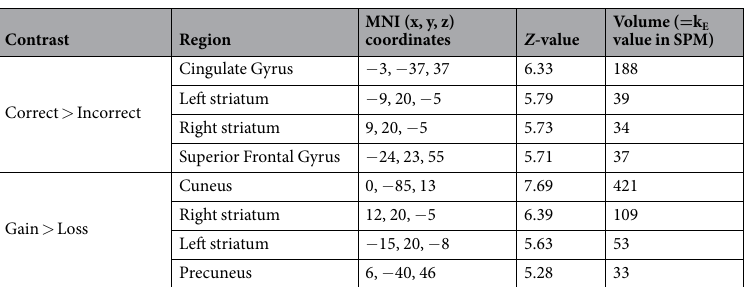
Fig. 3a, and Table 2). The main effect of Outcome (Gain > Loss) resulted in activation in four task-related areas (N = 19; FWE-corrected, p < 0.05): left striatum, right striatum, cuneus, and precuneus (see Fig. 3b, and Table 2). No significant interaction effects were found. However, because of overlapping brain regions in both main effects, we performed a conjunction analysis in order to investigate shared common processes for Advice and Outcome. Results showed two overlapping brain areas (see Fig. 3c): left striatum (33 voxels; MNI = − 12, 17, − 8; FWE-corrected, p < 0.05), and right striatum (34 voxels; MNI = 9, 20, − 5; FWE-corrected, p < 0.05). ROIs. For the ROI analyses we focused on the parameter estimates of the left and right anatomical striatal clusters for the whole-brain contrast Gain versus Loss. Our main interest was to disentangle subtle differences in striatal activation following the four different events: Correct-Gain, Correct-Loss, Incorrect-Gain, Incorrect-Loss. We used parameter estimates of the left and right anatomical striatal clusters, and performed paired t-tests for Correct-Gain compared to Incorrect-Gain and Correct-Loss compared to Incorrect-Loss. Results showed significant differences for both pairs with increased striatal activation when giving the correct advice compared to incorrect advice irrespective of monetary outcome (see Fig. 4): Correct-Gain versus Incorrect-Gain (left stri- atum: M = 2.72, SD = 3.26, t (18) = 3.63, p = 0.002; right striatum: M = 2.42, SD = 3.08, t (18) = 3.42, p = 0.003), Correct-Loss versus Incorrect-Loss (left striatum: M = 2.64, SD = 2.17, t (18) = 5.30, p < 0.001; right striatum: M = 2.62, SD = 2.13, t (18) = 5.35, p < 0.001), and Correct-Loss versus Incorrect-Gain (left and striatum: n.s., p s > 0.18). The effects remained significant after Bonferroni correction.